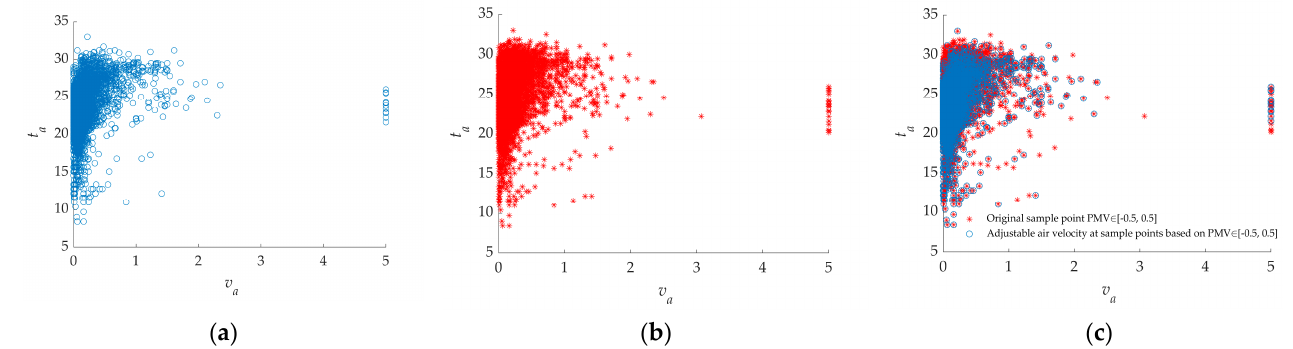
Figure 10. Adjustable air velocity at sample points based on PMV ∈ [ − 0.5, 0.5]; ( a ) original sample point PMV ∈ [ − 0.5, 0.5]; ( b ) original sample points PMV ∉ [ − 0.5, 0.5], but can be adjusted by air velocity; ( c ) sample points adjusted by air velocity to meet optimum comfort.